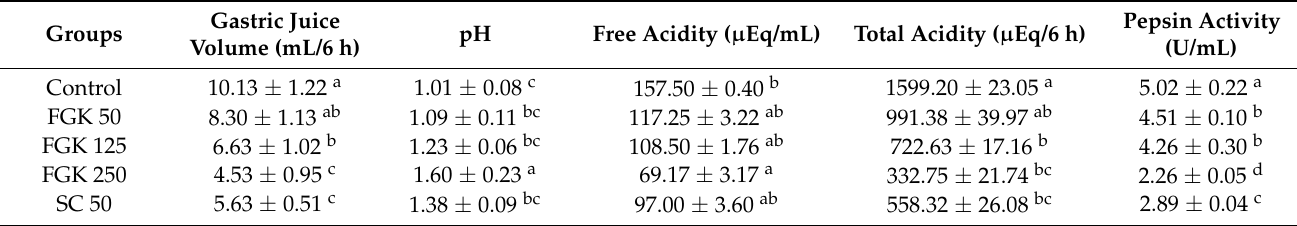
Table 3. Effect of FGK extract on gastric secretions in pyloric ligation